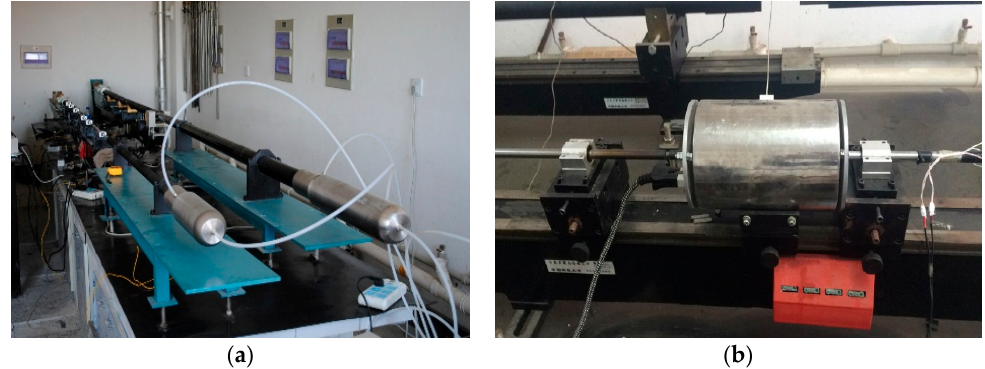
Figure 1. SHPB apparatus with resistance ‐ heated furnace: ( a ) SHPB apparatus, ( b ) resistance ‐ heated furnace. Figure 1. SHPBapparatuswithresistance-heatedfurnace: ( a )SHPBapparatus, ( b